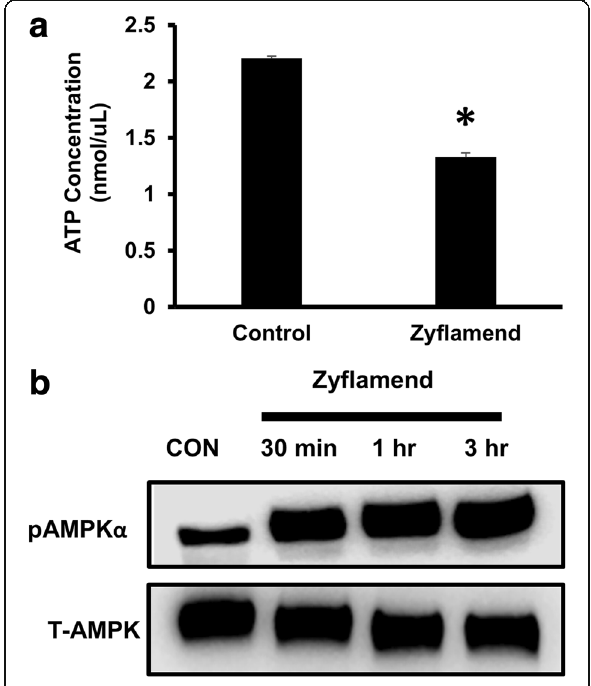
Fig. 2 The effects of Zyflamend on cellular ATP levels and phosphorylation of AMPK α (at Thr172) in CWR22Rv1 cells. a ATP levels of CWR22Rv1 cells treated in the presence or absence of Zyflamend (200 μ g/mL, 30 min). b The effects of Zyflamend (200 μ g/mL, 30 min – 3 h) on phosphorylation of AMPK α in CWR22Rv1 cells. Data is presented as mean ± SEM, n = 4. Abbreviations: Con,